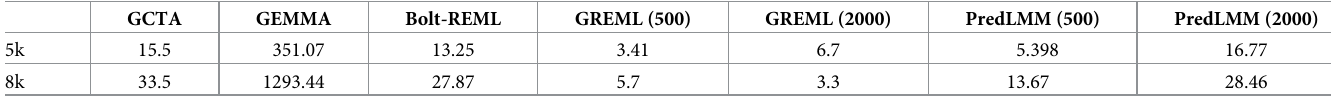
Table 1. Time comparison of different methods in seconds for Simulation Study 1 with 5k (8k SNPs) and 8k (13k SNPs) individuals.